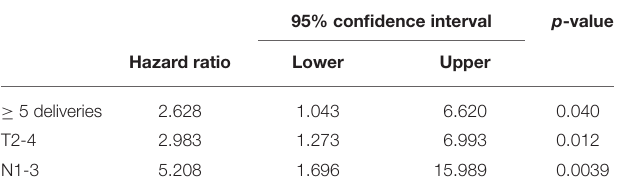
TABLE 6 | Having five or more deliveries at the time of breast cancer diagnosis is indicator of poor prognosis in multivariate